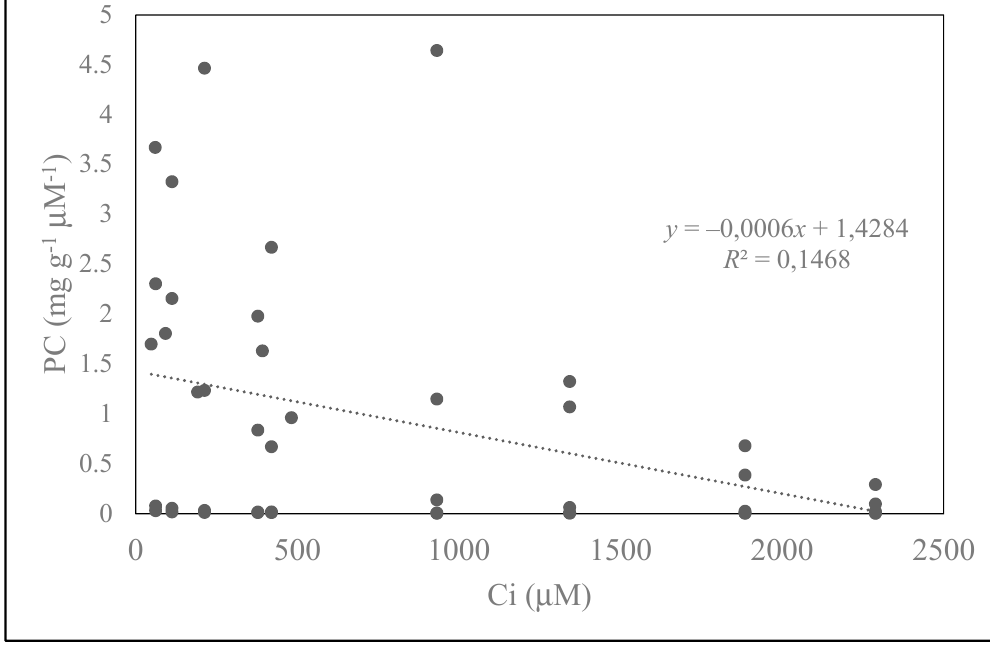
Figure 7. Partition coefficients for Pb(II) sorption by Nat-CLI and acid-modified clinoptilolite rich tuffs (PC) as a function of the initial concentration of lead in solution (Ci).